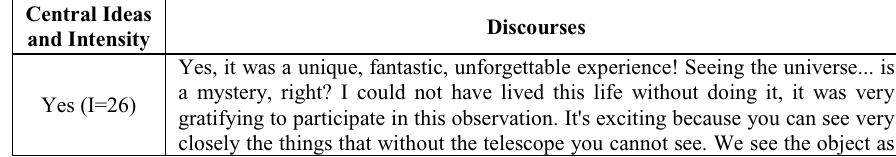
Table 4. Discourses and central ideas obtained when asked “did the observation through the telescope meet your